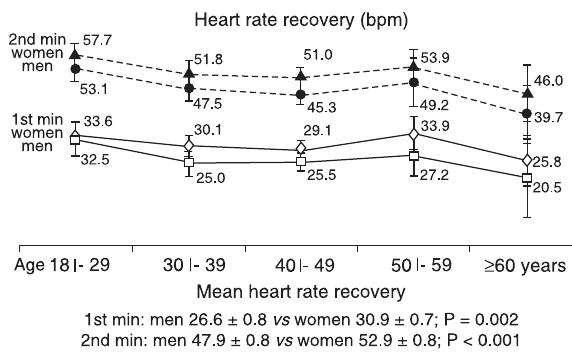
Figure 1. Mean heart rate recovery in the 1st and 2nd min after exercise relative to age and gender. (Student t -test).